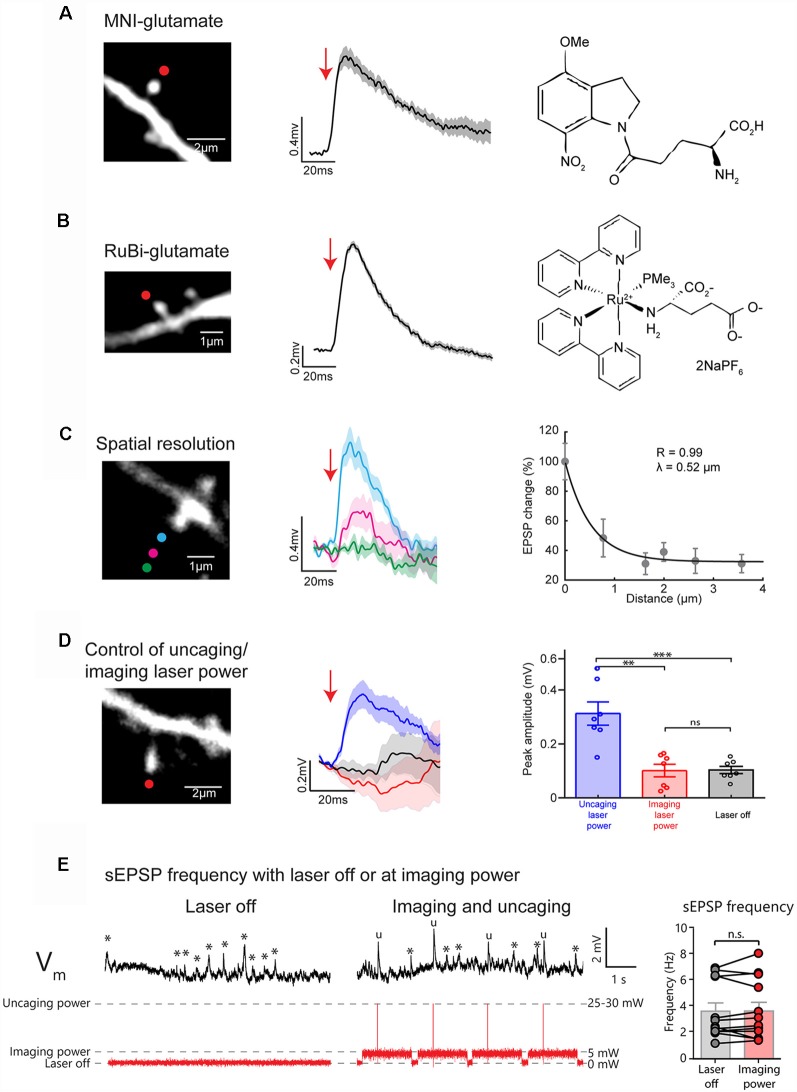
Uncaging caged glutamate at single spines evokes uncaging (u)EPSPs detected at the soma of layer 5 (L5) pyramidal neurons with high spatial precision. (A) Representative 2P uncaging of MNI-glutamate experiment in a single spine. (Left) Two-photon (2P) image of a single spine in the basal dendrites of a L5 pyramidal neuron (red dot indicate site of uncaging). (Center), 2P uncaging of caged MNI-glutamate near the selected spine induces a uncaging-evoked excitatory postsynaptic potential (uEPSP) measured at the soma in current-clamp configuration. The tick line and the shaded area represent the mean ± standard error of the mean (SEM) of 10 uEPSP generated at this spine. (Right) Chemical formula for MNI-glutamate. (B) Representative 2P uncaging of RuBi-glutamate experiment in a single spine. (Left), 2P image of a single spine on the basal dendrites of a L5 pyramidal neuron (red dot indicate site of uncaging). (Center) 2P uncaging of caged RuBi-glutamate near the selected spine induces a uEPSP measured at the soma in current-clamp configuration. The tick line and the shaded area represent the mean ± SEM of 10 uEPSPs generated at this spine. (Right) Chemical formula for RuBi-Glutamate. (C) Representative 2P uncaging of MNI-glutamate in a single spine spatial resolution experiment. (Left) 2P image of a single spine in the basal dendrites of a L5 pyramidal neuron with colored circles showing the location of different MNI-glutamate uncaging spots. (Center) 2P uncaging in the selected spine at different locations and their corresponding uEPSPs measured at the soma. The tick line and the shaded area represent the mean ± SEM of 10 uEPSPs generated at this spine. (Right) Relationship between the distance of the uncaging spot from the spine and the evoked uEPSP. Each dot corresponds to the mean ± SEM of 10 uEPSPs generated a given distance from a single spine. (D) Representative experiment to explore the effect of 2P uncaging pulses in a single spine with imaging or uncaging power. (Left) 2P image of a single spine on the basal dendrites of a L5 pyramidal neuron showing the uncaging spot (red dot). (Center) 2P uncaging of RuBi-glutamate right next to the selected spine using uncaging (blue trace) or imaging laser power (red trace) while uEPSP are recorded at the soma. Note the absence of induction of a uEPSPs when short pulses at imaging laser power were given. Black traces represent the averaged membrane potential recorded (10 trials) while the laser was off, 100 ms before the onset of uncaging laser pulses. Thicker traces are an average of 10 uEPSPs, and shaded areas illustrate ± SEM. (Right) Plot showing the peak amplitude (mV) of the responses measured in seven independent experiments, from n = 7 independent spines, where the average triggerd 2P uEPSP (10 trials per spine) was recorded at either uncaging (blue bar and points) imaging laser power (red bar and dots), or when the laser was off (black bar and dots). **p < 0.01; ***p < 0.001; ns, not significant. (E) Example traces of membrane voltage recorded at the soma of a L5 pyramidal neuron while the laser was off (Left) or at imaging laser power during an uncaging/imaging protocol (Center). Asterisks indicate the presence of a spontaneous EPSPs (sEPSPs) while “u” marks uEPSPs. Note the similar frequency of sEPSPs (*) when the laser is off or at imaging laser power. (Right) Plot represents the frequency of events measured over a 30–60 s period before and during the uncaging/imaging protocol for each spine (n = 12 cells). ns, not significant. The first 50 ms following uncaging pulses were not included in this analysis.